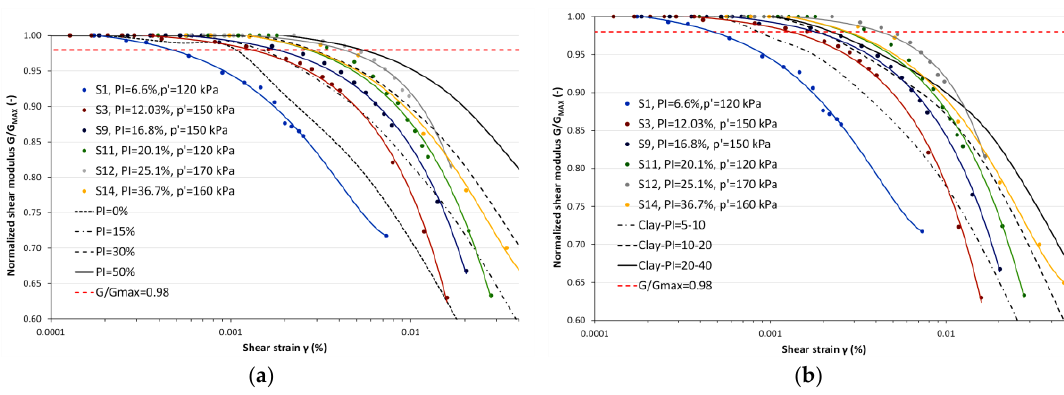
Figure 7. The example of normalized shear modulus ( G/G MAX ) degradation curves compared to Vucetic and Dobry [32] ( a ) and Sun et al. [59] ( b ) curves for samples [1,3,9,11,12,14] with a different plasticity index PI .